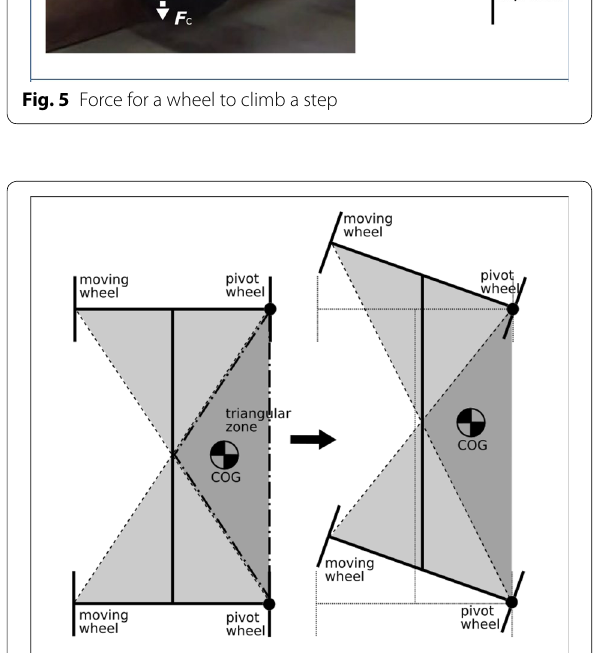
Fig. 6 Pace gait and COG